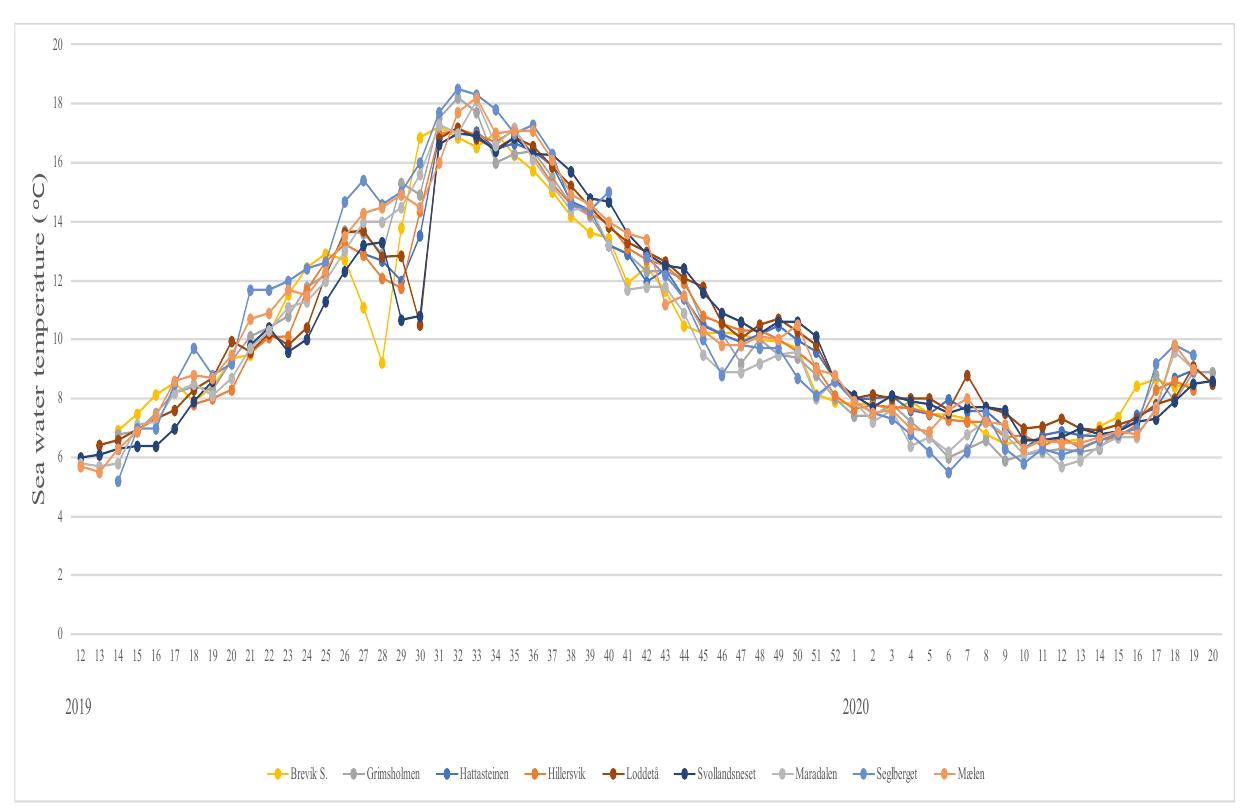
Figure 2. The facilities in experiment 2 with green dots (AcuLice treatment) and orange dots (refer- ences without AcuLice treatment) located in Hardangerfjorden.